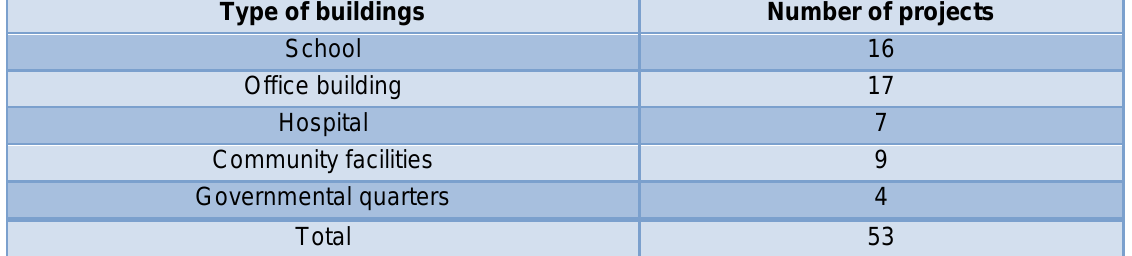
Table 3 Various Types of Completed Buildings with Green Roof Features from 2001 to 2006 (Legislative Council 2006)